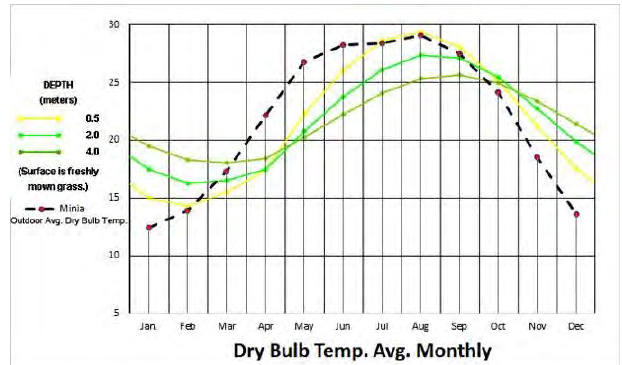
Figure 4. Predicting temperatures under the ground surface, at depths of 0.5, 2.0, 4.0 m. The stable thermal comfort conditions are high with more depths under a ground